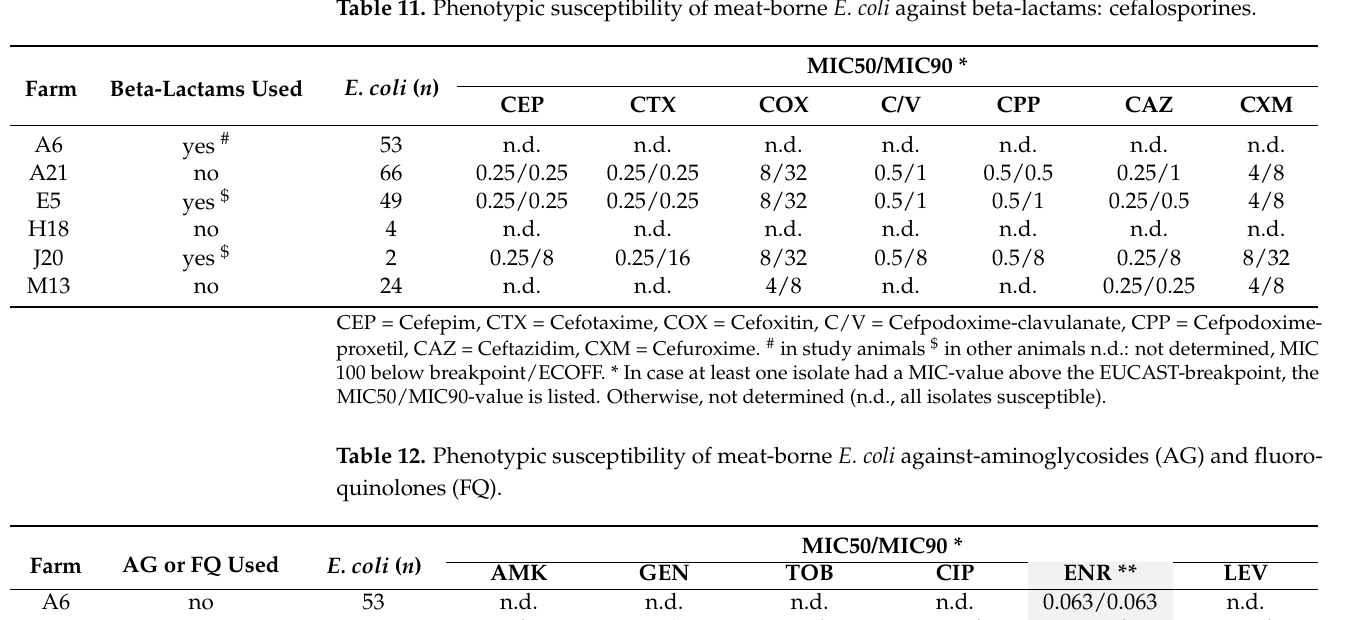
Table 11. Phenotypic susceptibility of meat-borne E. coli against beta-lactams: cefalosporines.